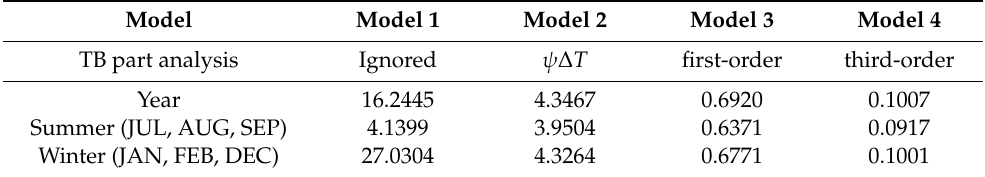
Table 9. The TB analysis method for the models and RMSE of each model for annual heat